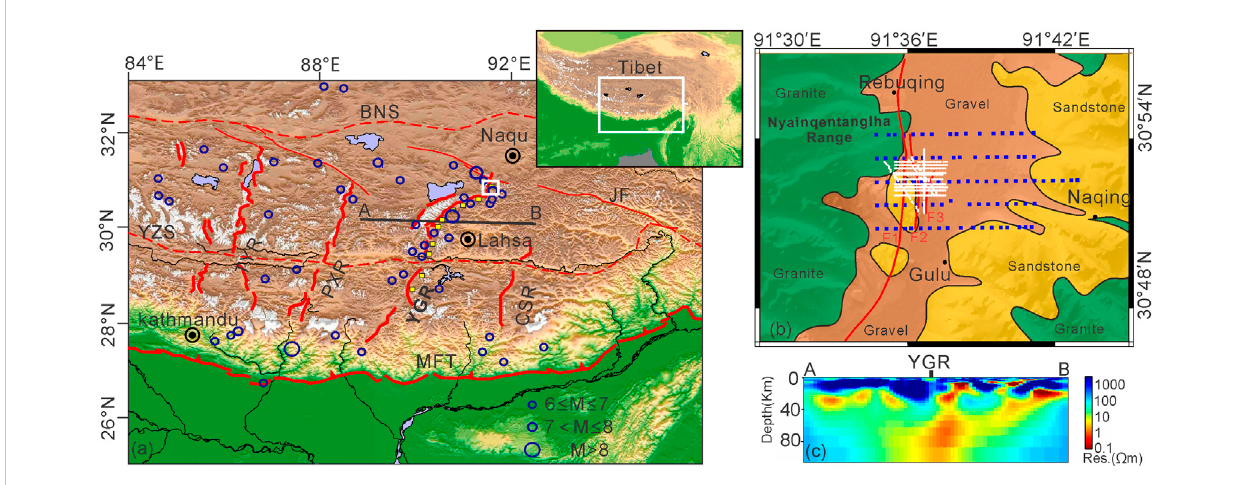
FIGURE 1 Geologic setting and sounding sites (A) Tectonic framework of Yadong-Gulu rift (modi fi ed from Shi et al., 2020). A large number of earthquakes are distributedaroundYGR,suggestingthatYGRhas intenseactivity.Reddotsaresutures.Redlinesarefaults. Bluecirclesareearthquakes.Yellowdiamonds aregeothermalmanifestations.BlacklineisthepreviousMTsection,asshowninFigure1C. (B) SoundingsitesoverlaponthegeologyofGulugeothermal fi led. Jiulazi-SanXung fault is consist of fault F1, F2 and F3. Nyainqentanglha Range is mainly composed of granite. The middle Jurassic Mali formation sandstone (J 2 m) and Quaternary gravel (Q) are the sedimentary strata of GGF. Blue diamonds are MT sites. White dots are AMT sites. (C) Electrical model of section AB (modi fi ed from Wang G et al., 2017). High conductors of mantle origin are distributed in the subsurface of